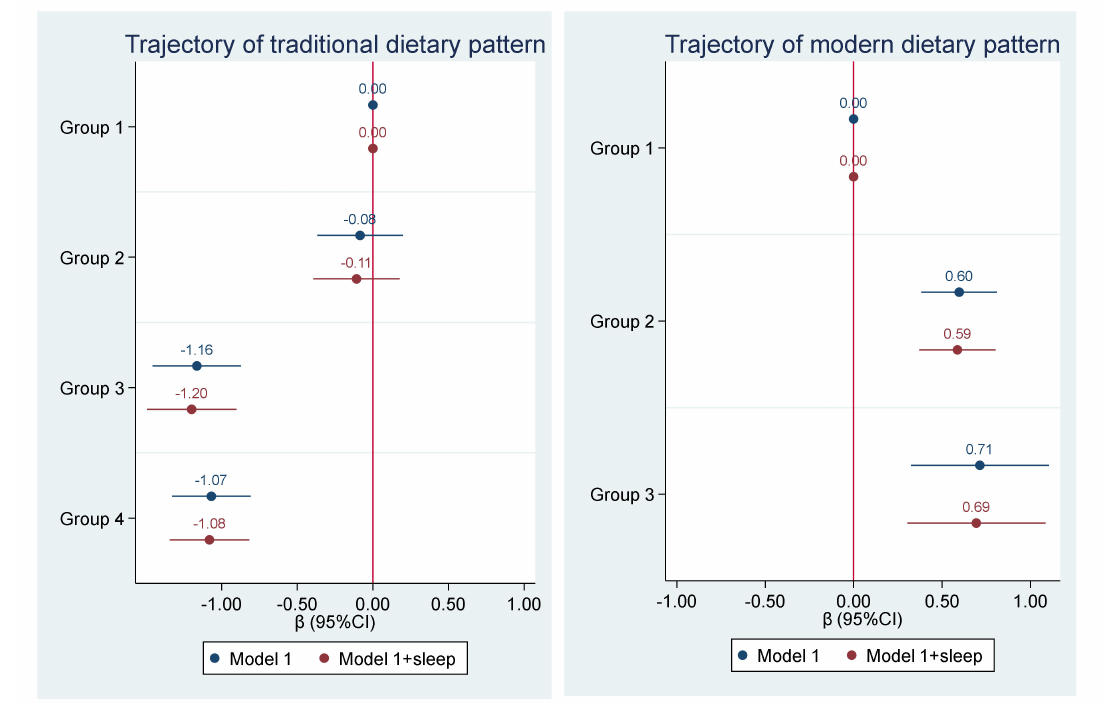
Figure 2. Association between trajectories of dietary patterns (between 1991 and 2009) and BMI in 2009 * . * Model 1 is adjusted for age, sex, education, income, urbanization, smoking, alcohol drinking, and physical activity and hypertension. Sleep was treated as a continuous variable in the model. Trajectories of the traditional dietary pattern: Group 1 (low and rapid increase), Group 2 (medium and slow increase), Group 3 (high and stable), Group 4 (high and slow decrease). Trajectories of the modern dietary pattern: Group 1 (low and slow increase), Group 2 (medium and moderate increase), Group 3 (high and rapid